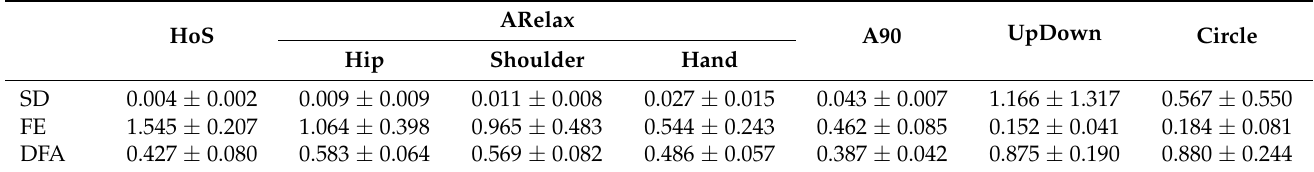
detrended fluctuation analysis) of motor variability in every situation.